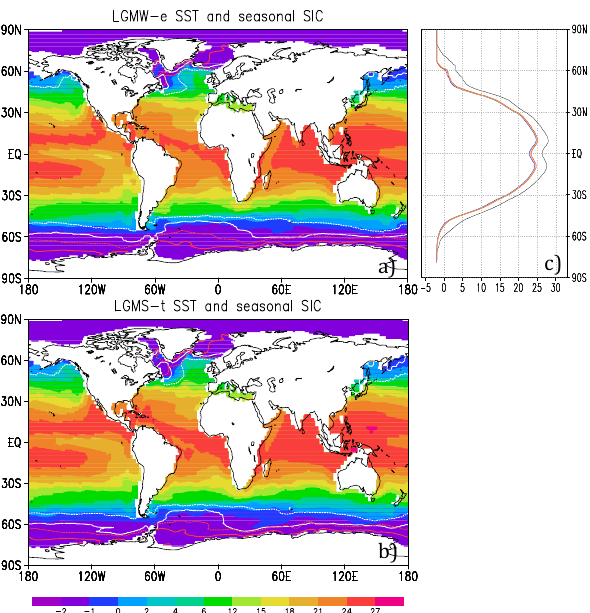
Figure 5 Annual mean of sea surface temperature (SST, unit: °C, shaded) Fig. 5. Annual mean of sea surface temperature (SST, unit: ◦ C, and seasonal sea ice concentration (SIC, unit: %, contour) in the LGMW-e shaded) and seasonal sea ice concentration (SIC, unit: %, contour) (a) and LGMS-t deep (b). The white lines represent winter for each in the LGMW-e (a) and LGMS-t deep (b) . The white lines repre- hemisphere, while the red line represents summer. The dashed lines indicate sent winter for each hemisphere, while the red line represents sum- 15% SIC, and solid lines 90% SIC. (c) Zonal mean of global SST in PI mer. The dashed lines indicate 15% SIC, and solid lines 90% SIC. (c) Zonal mean of global SST in PI (black), LGMW-e (blue) and (black), LGMW-e (blue) and LGMS-t (red). Units: °C. LGMS-t deep (red). Units: ◦ C.